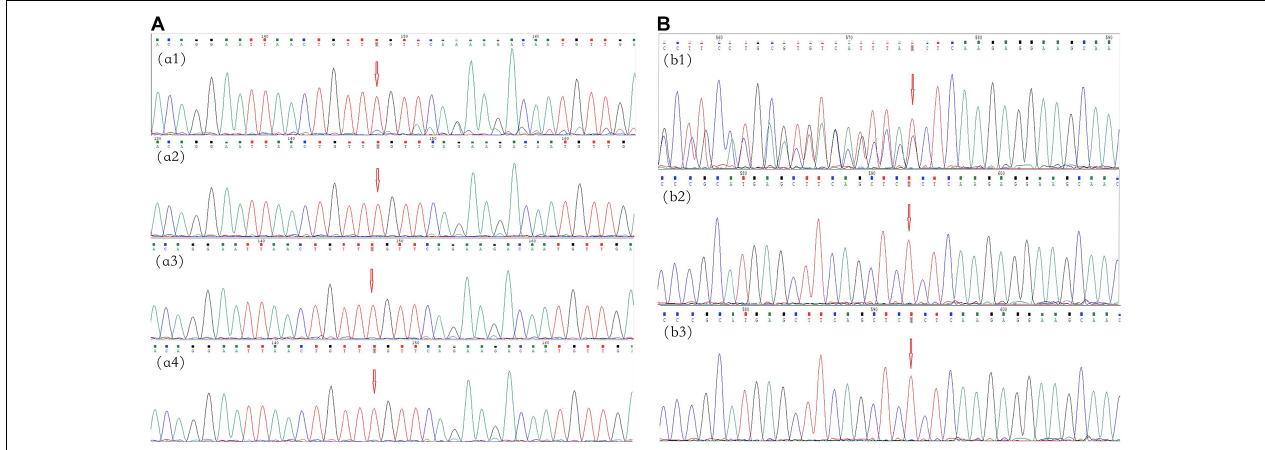
FIGURE 3 | Mutational analysis of the neurofibromatosis (NF) patients in families 4 and 5. The red arrows indicate the mutation sites. (A) Family 4: the c.495_498del:p.Thr165fs frameshift variant in NF1 in exon 5 in cutaneous neurofibromas from proband II-4 ( a1 ) ; there was no mutation in the peripheral blood, oral mucosa, or hair ( a2 – a4 , respectively). (B) Family 5: the c.36_39del:p.Ser12fs frameshift variant in NF2 in exon 1 in proband II-1 ( b1 ) ; there were no mutations in her father and mother ( b2 , b3 ,